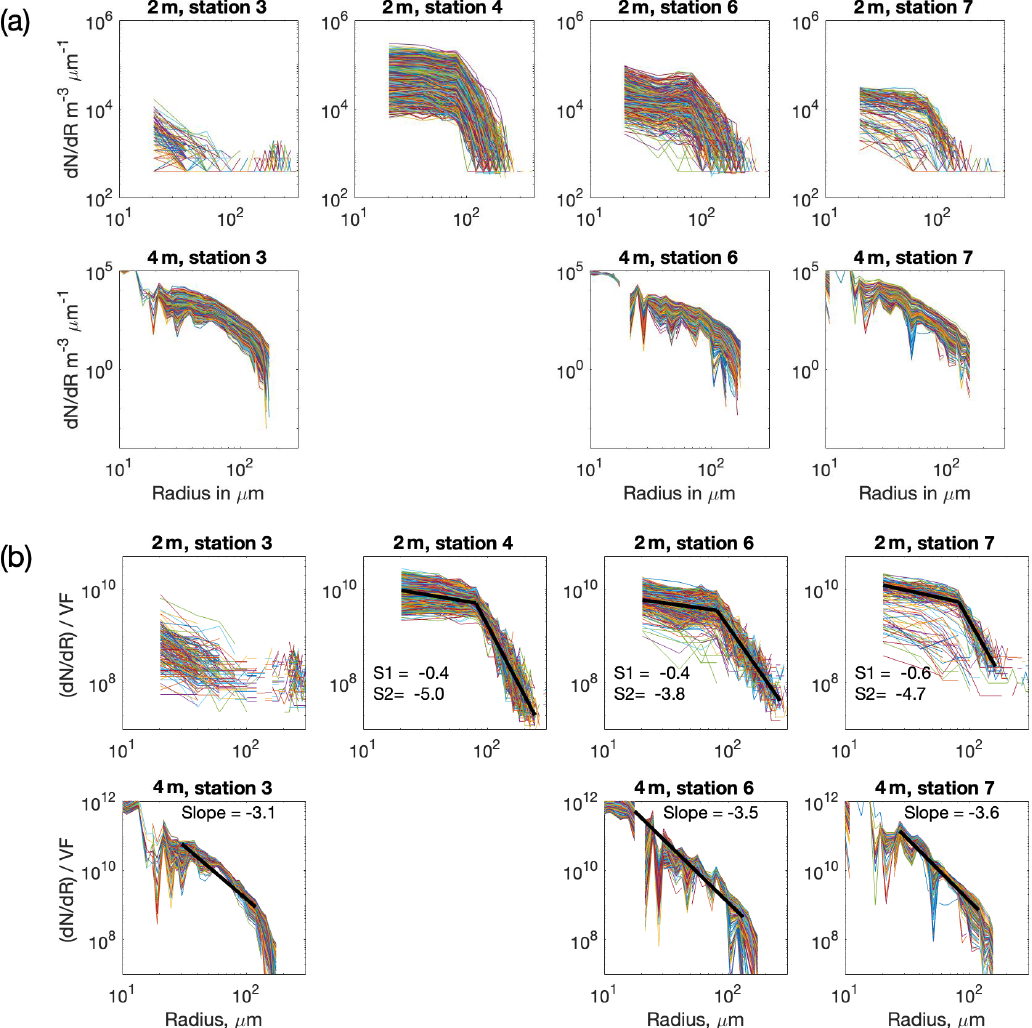
Figure 2. All 1s bubble size distributions for every deployment, for both camera (at 2m) and resonator (at 4m). (a) Number of bubbles per micrometre radius increment per unit volume, d N / d R (m − 3 , µm − 1 ) . (b) The same data, but each distribution is normalised by its own void fraction (d N / d R ) / VF (m − 3 , µm − 1 ) . No resonator data was available for station 6. Power-law fits for each deployment are shown in the lower set, with the two slopes labelled as S1 and